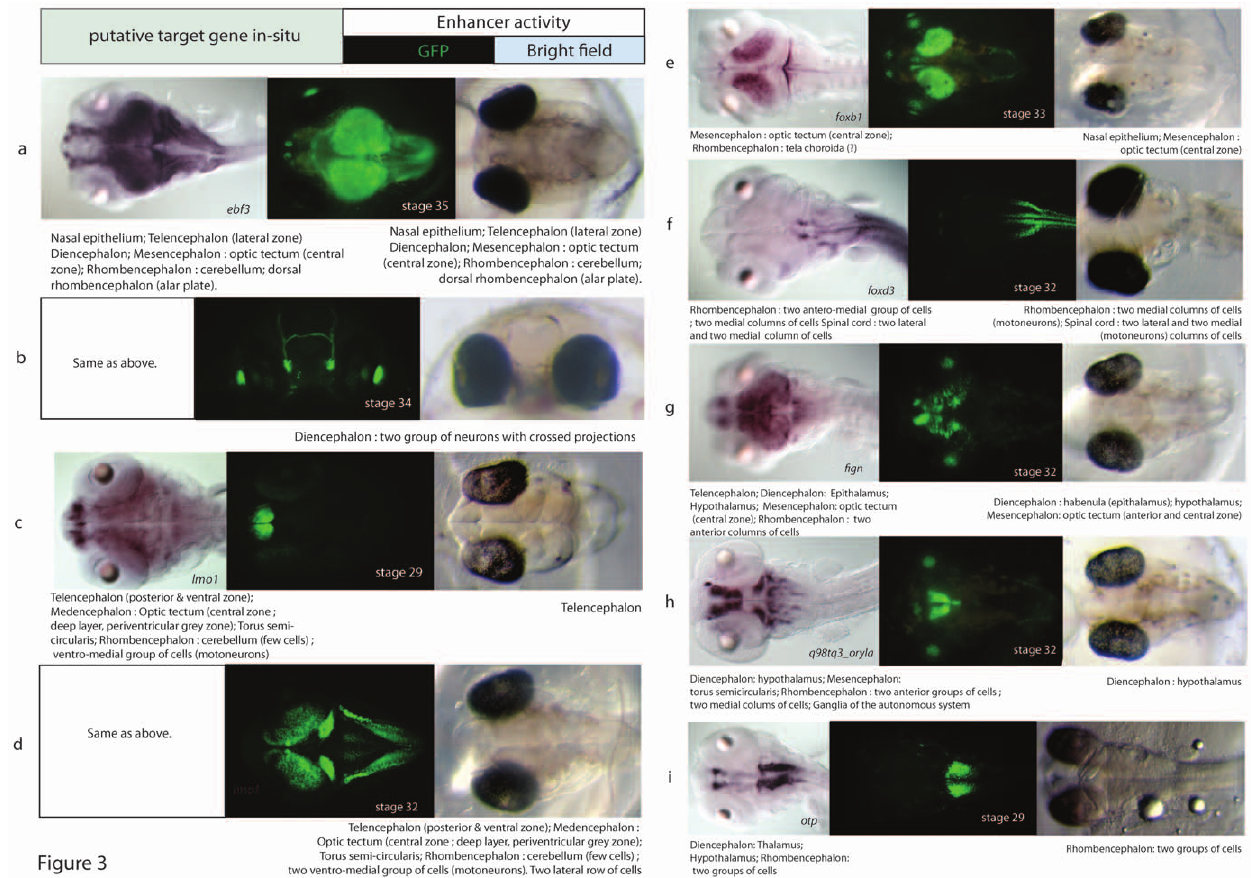
Figure 3. Summary of the expression patterns in stable lines. (a–i) In-situ hybridization of the flanking gene (left) and stable lines expressing GFP under the control of the corresponding CRM (right). MEDMOD046561 did not show detectable enhancer activity. For more details on the expression patterns of the transgenic lines, see Supplementary Figures 5–9. All embryos are shown in a dorsal view unless stated otherwise. ( a ) MEDMOD021953, ( b ) MEDMOD021885 (frontal view), ( c ) MEDMOD062537, ( d ) MEDMOD062451, ( e ) MEDMOD074008, ( f ) MEDMOD070042, ( g ) MEDMOD046007, ( h ) MEDMOD045693, ( i ) MEDMOD086628.